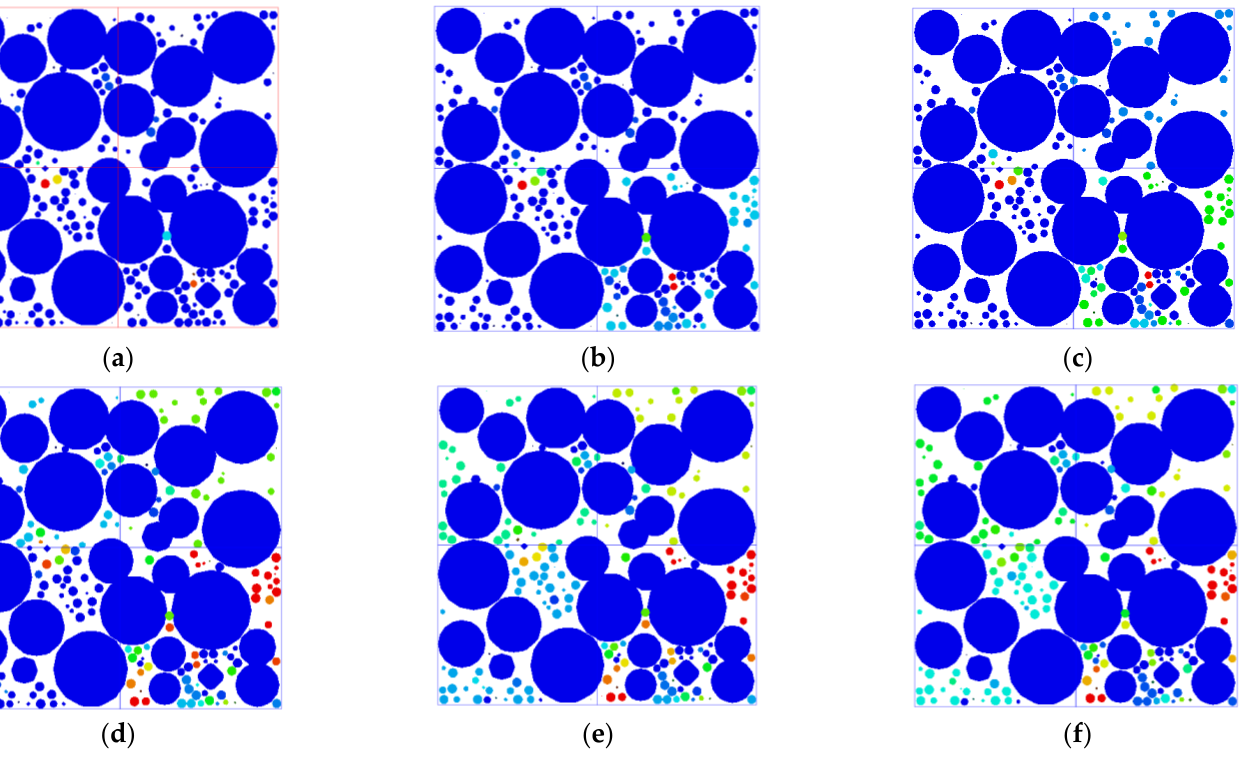
Figure 4. Initiation state of fine particles under the seepage. ( a ) v = 0.00 cm/s, ( b ) v = 0.40 cm/s, ( c ) v = 0.50 cm/s, ( d ) v = 0.65 cm/s, ( e ) v = 0.70 cm/s, ( f ) v = 0.80 cm/s.